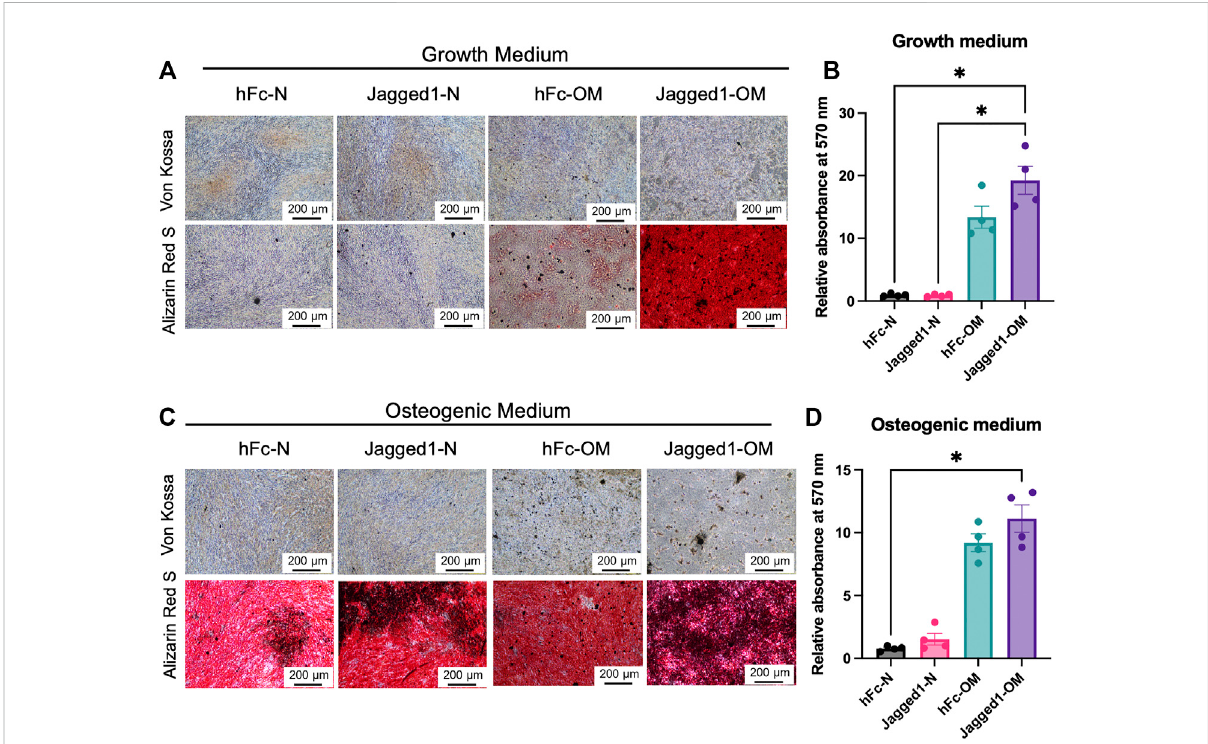
FIGURE 4 Jagged1-treated hDPSC dECM promotes mineralization ability of SCAPs. SCAPs were seeded on dECM and maintained in the growth medium (A) or osteogenic induction medium (C) . Mineralization was observed using Von Kossa and Alizarin Red S staining. The deposited Alizarin Red S was solubilized and the relative absorbance at 570 nm was illustrated (B,D) . Bars indicated a statistically signi fi cant